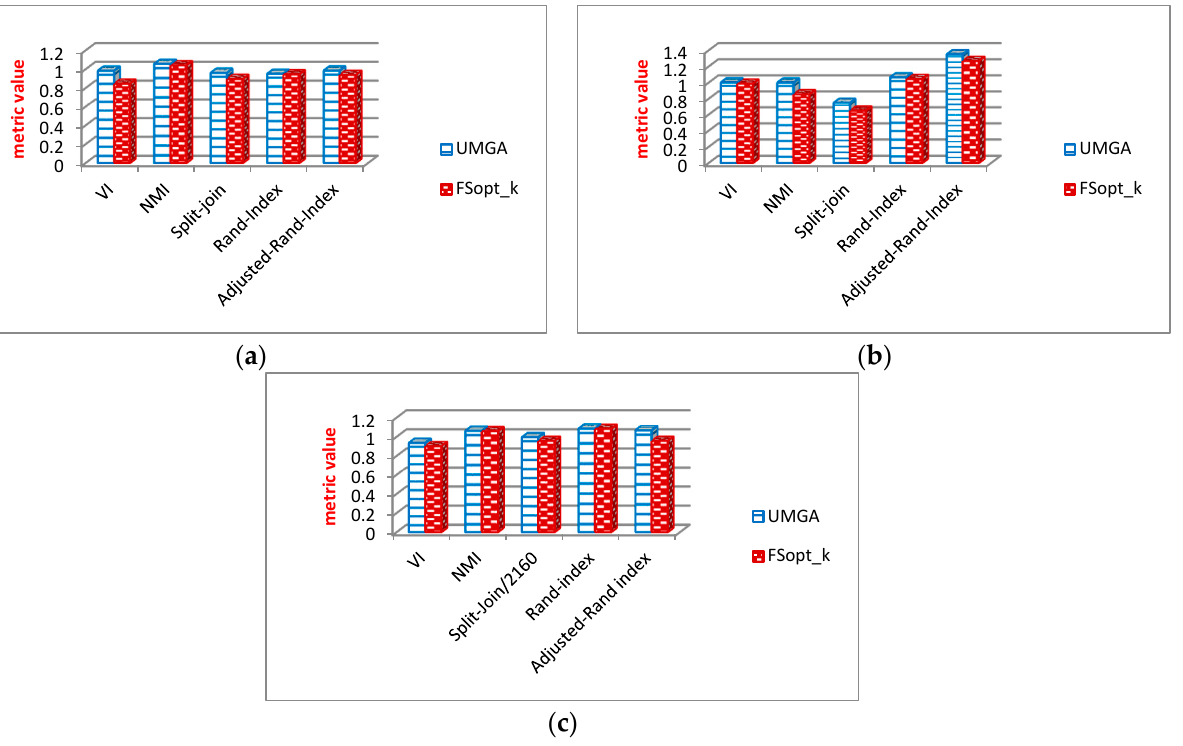
Figure 15. Evaluated values of community structure metrics on power grid for ( a ): ℒ = 0.05 , ( b ): ℒ = 0.1 , and ( c ): ℒ = 0.2 .